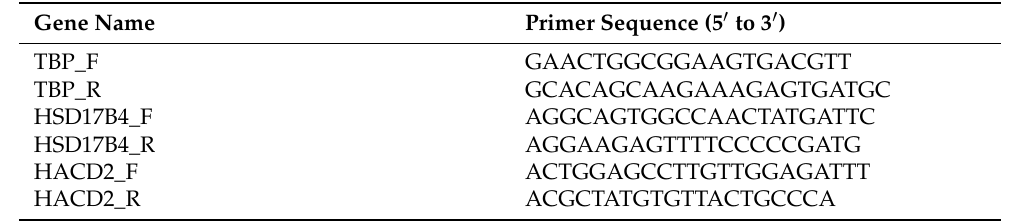
Table 2. RT-qPCR primer